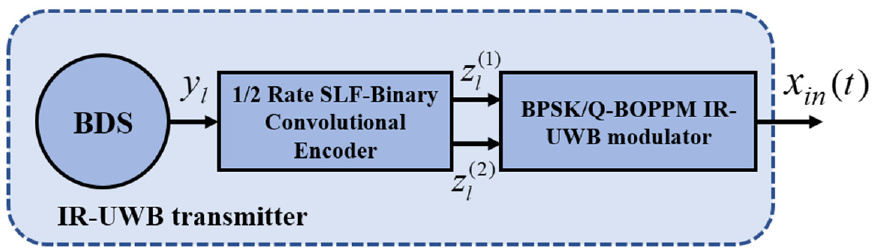
Figure 3. Spectral Line-Free (SLF) IR-UWB transmitter diagram block. BDS: Binary Data Source; SLF: Spectral Line-Free; BPSK: Binary Phase Shift Keying; Q-BOPPM: Quaternary Biorthogonal PPM.